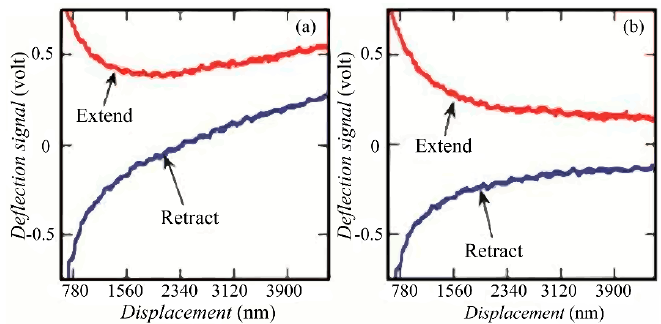
Figure 6. ( a ) Virtual deflection due to the relative motion of the detector; and ( b ) the deflection curve after removal of virtual deflection.